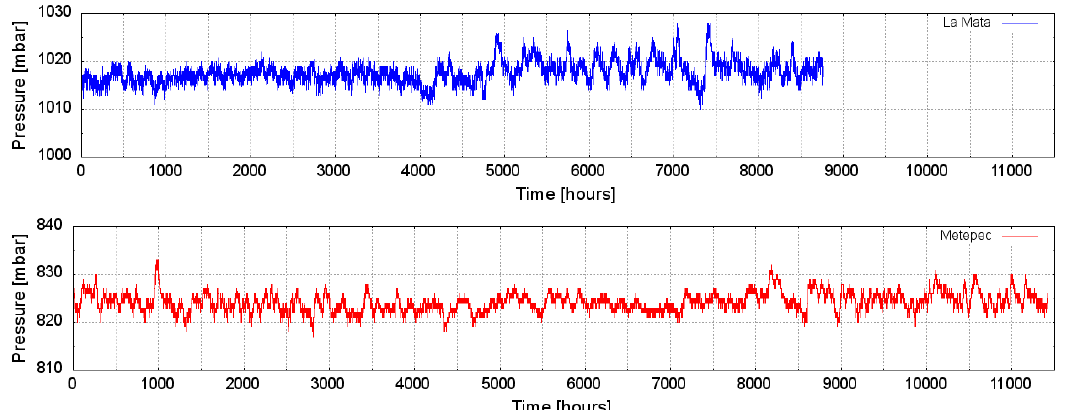
Figure 4. Barometric pressure time series from La Mata, Oaxaca (hourly averages), and Metepec, Hidalgo (ten-minute